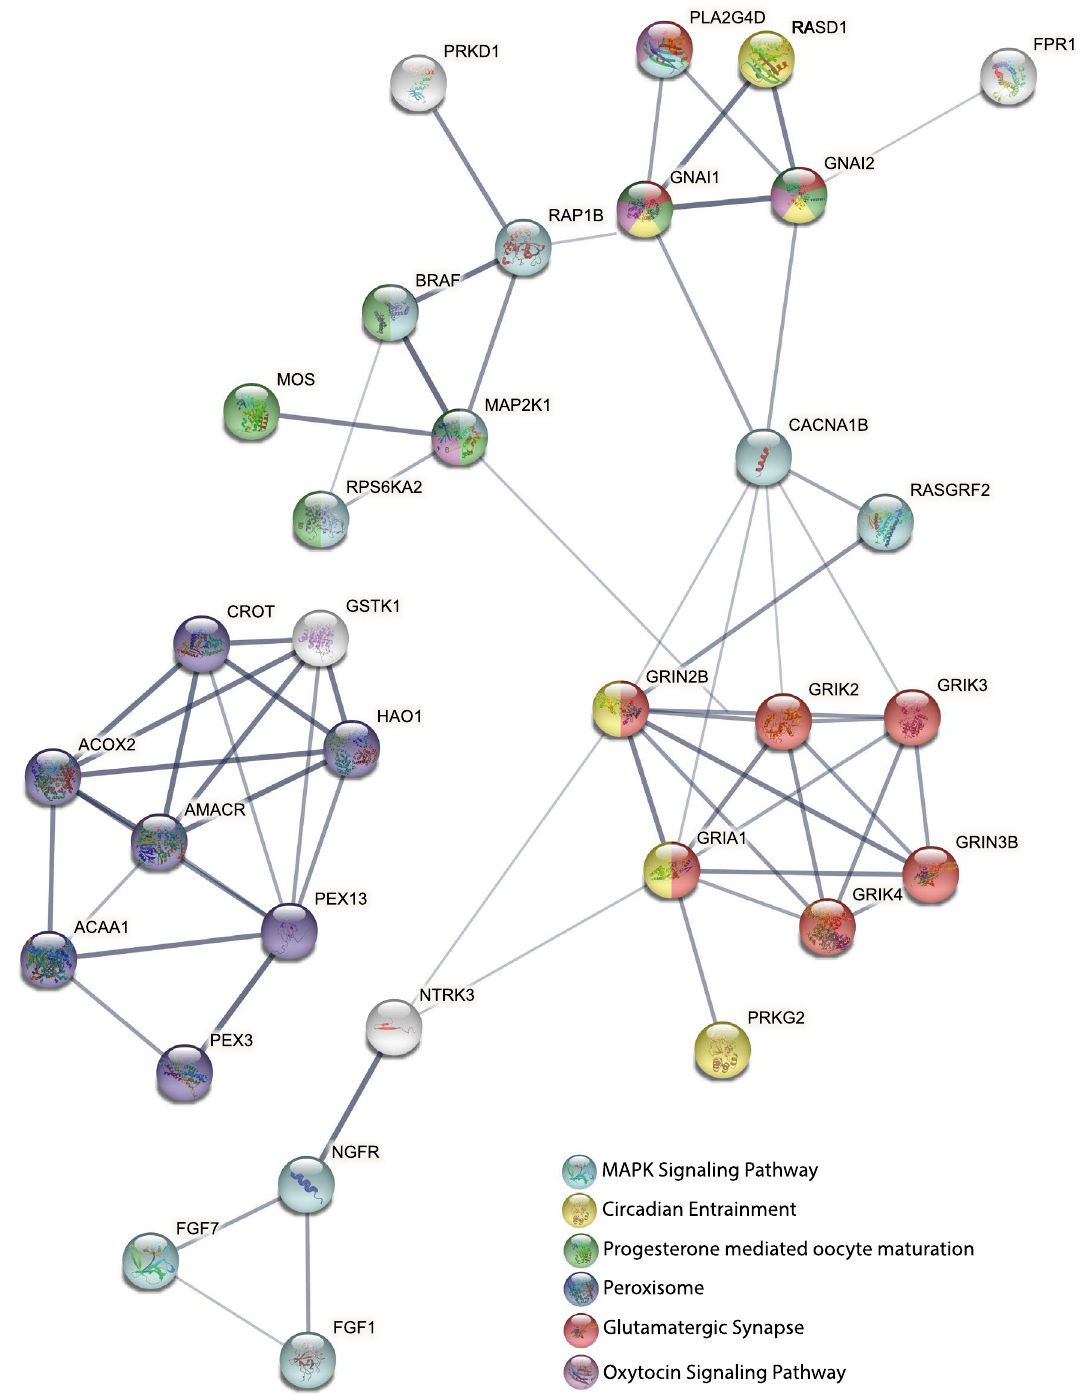
Figure 6. Protein–protein interaction network of DEGs. Color of the nodes indicates the pathway to which the genes belong. Edges show high confidence (0.9)